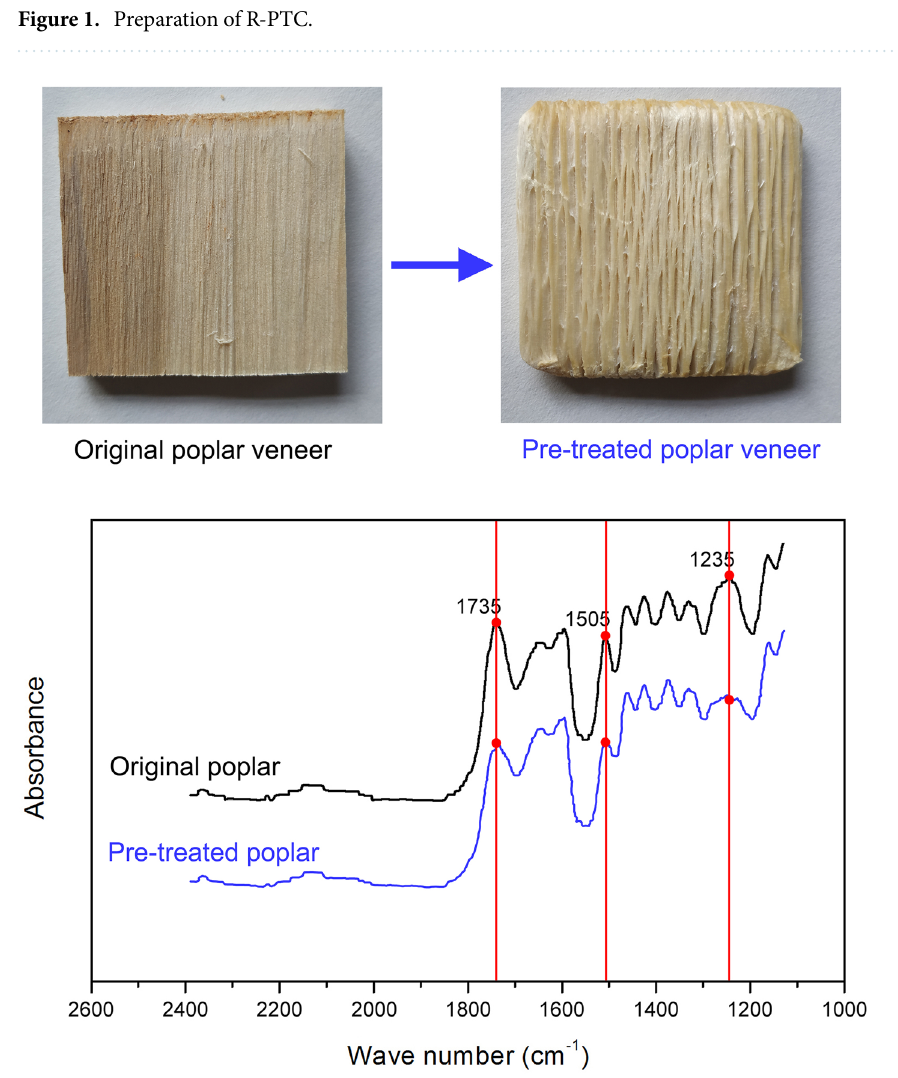
Figure 2. FTIR spectra: original, and pre-treated poplar